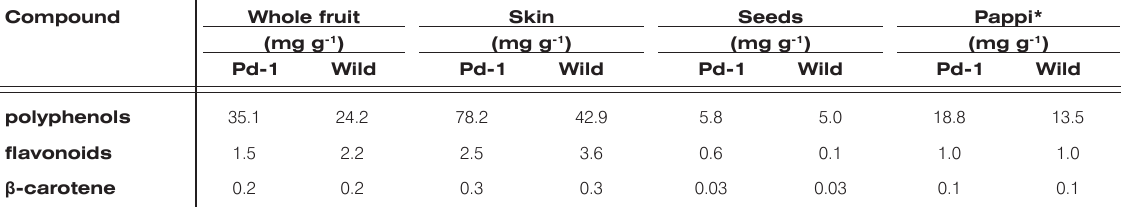
Table 3. Content of target compounds in cultivated and wild rosehip, water extraction at